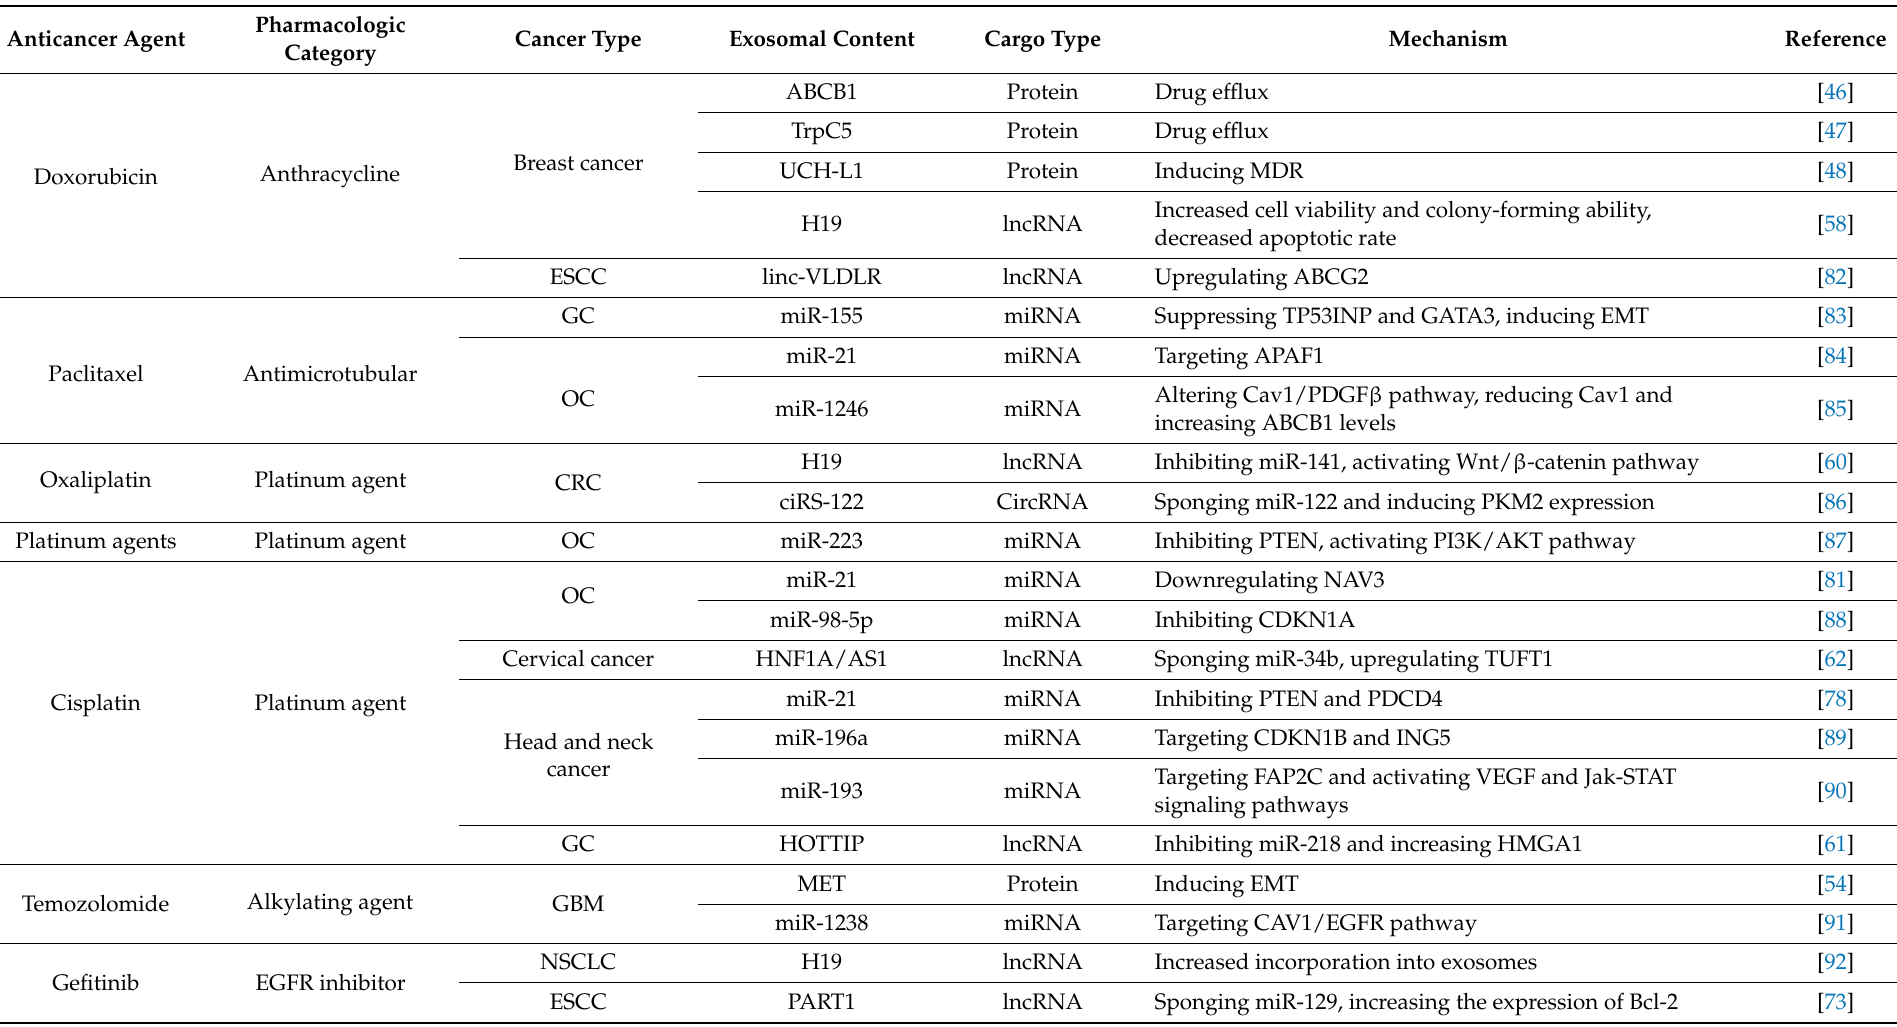
Table 2. Summary of anticancer drugs and exosomal cargo involved in drug